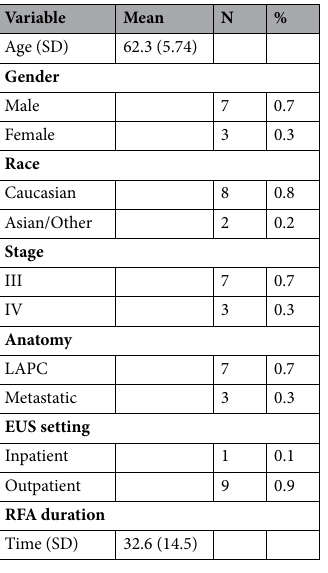
Table 1. Patient demographics.